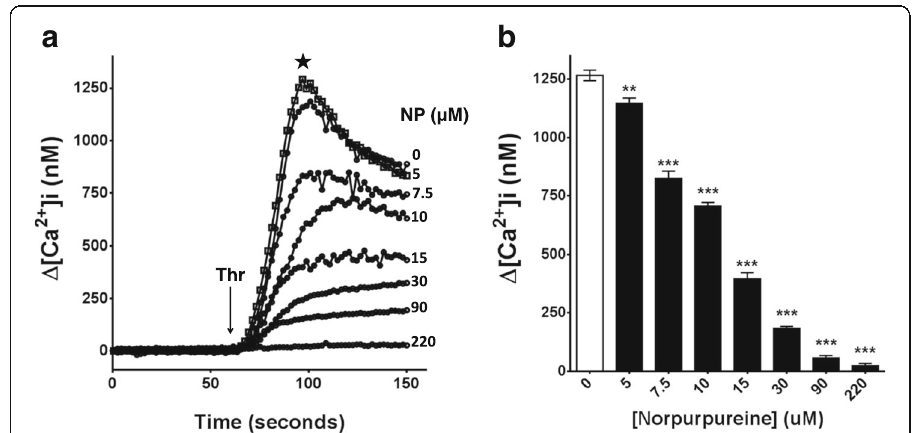
Fig. 5 Norpurpureine inhibits agonist-induced elevation of [Ca 2+ ] i in human platelets. a Typical superimposed traces of [Ca 2+ ] i changes stimulated by 0.075 U/ml thrombin (Thr) over time, in Fura-2-AM-loaded platelets pretreated with norpurpureine at the indicated concentrations. b Concentration-dependent inhibition of norpurpureine on the maximum elevation ( ★ in 5A, for each curve) reached by [Ca 2+ ] i after thrombin stimulation. Each data point is the mean±SD ( n =3), p <0.01(**), p <0.001(***) vs.